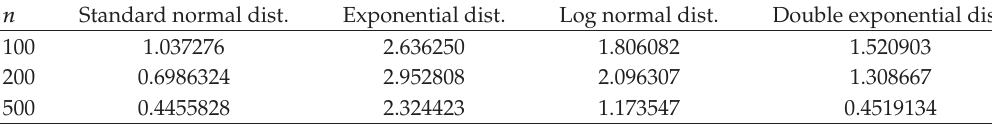
Table 5: The relative e ffi ciency (cid:4) R.E (cid:5) of h Method 1,opt . n Standard normal